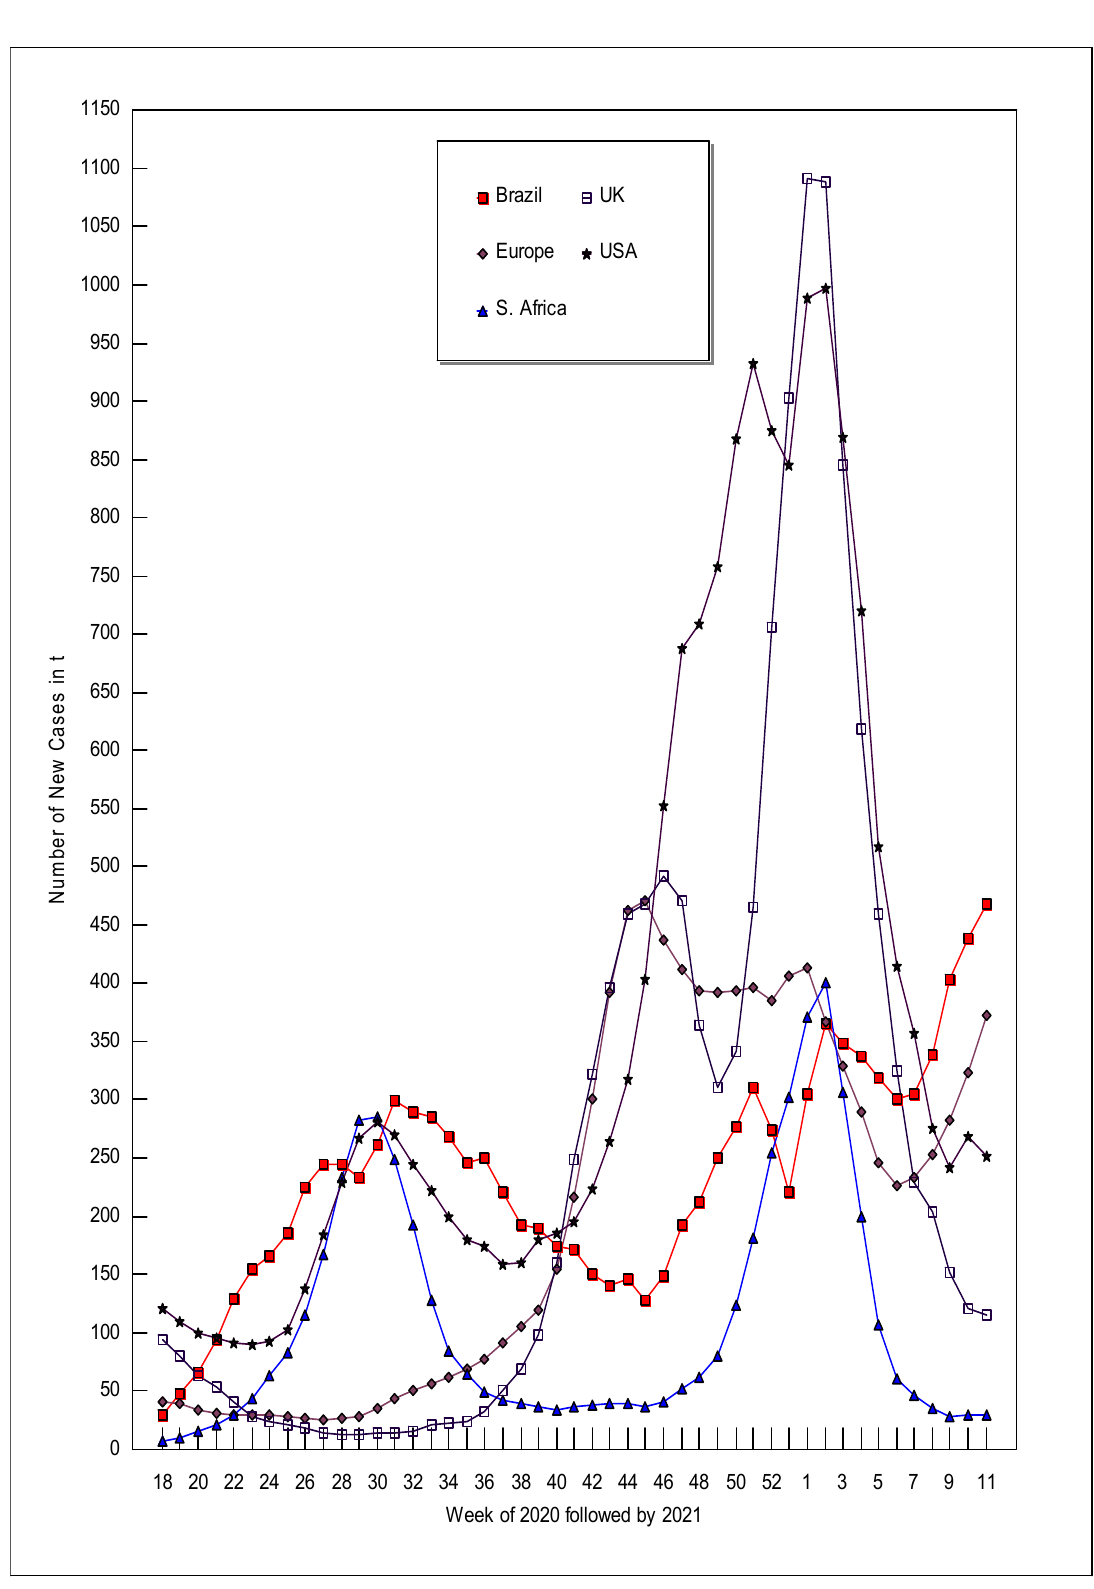
Figure 3. New cases of COVID-19 over time.